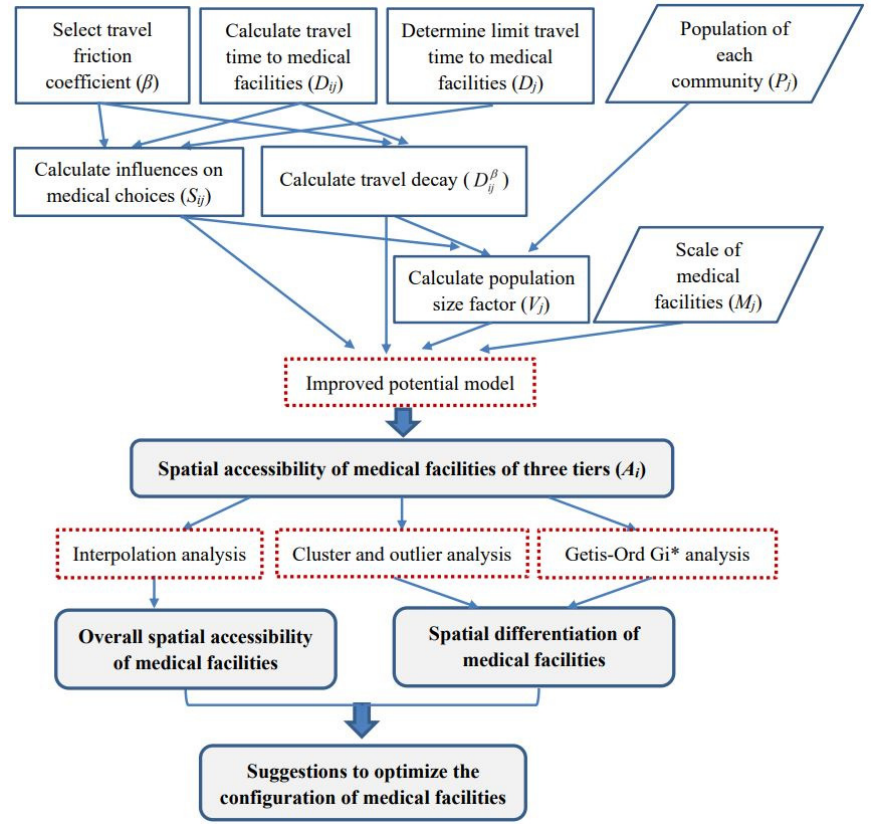
Figure 1. Methods workflow.